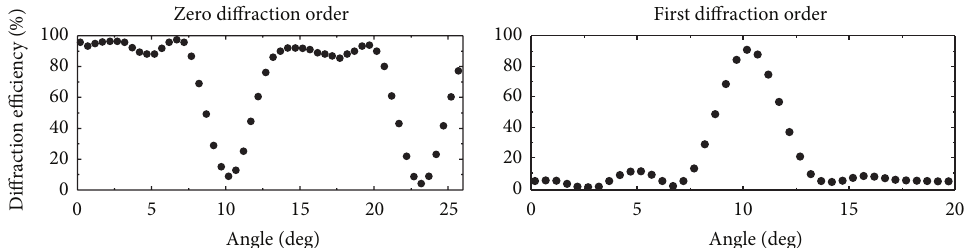
Figure 5: Angular selectivity curves for lens elements recorded at an angle of 10.5 ∘ on flexible glass substrate with the exposure energy of 60 mJ/cm 2 at spatial frequency of 300